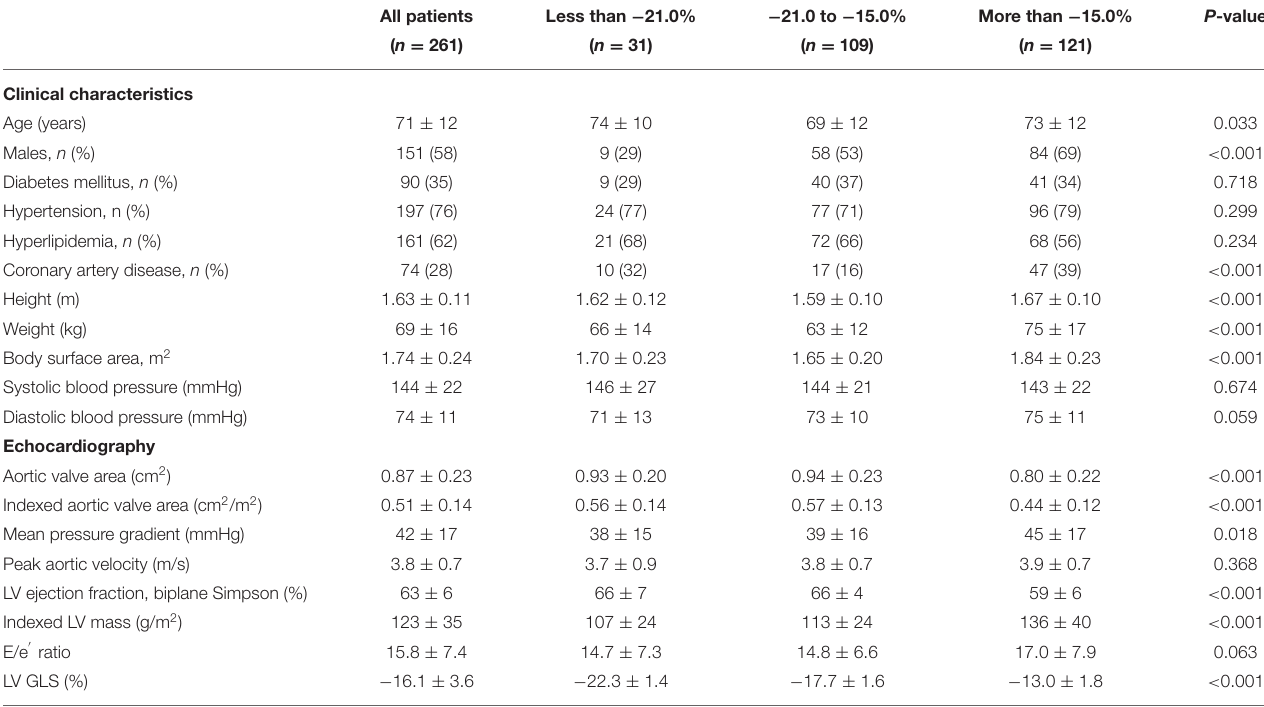
TABLE 3 | Characteristics of patients in the outcome cohort, stratified by global longitudinal strain. All patients Less than − 21.0% − 21.0 to − 15.0% More than −